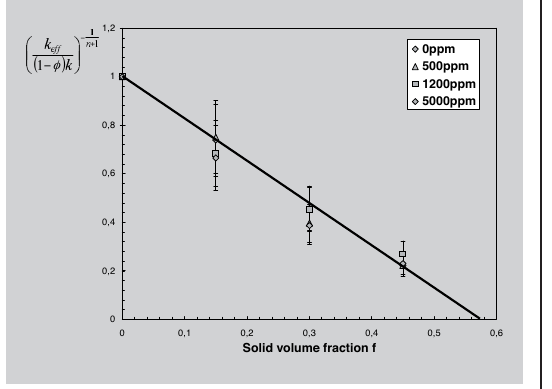
Figure 12: Normalized consistency as a function of solid volume fraction (The straight line corresponds to Eq.